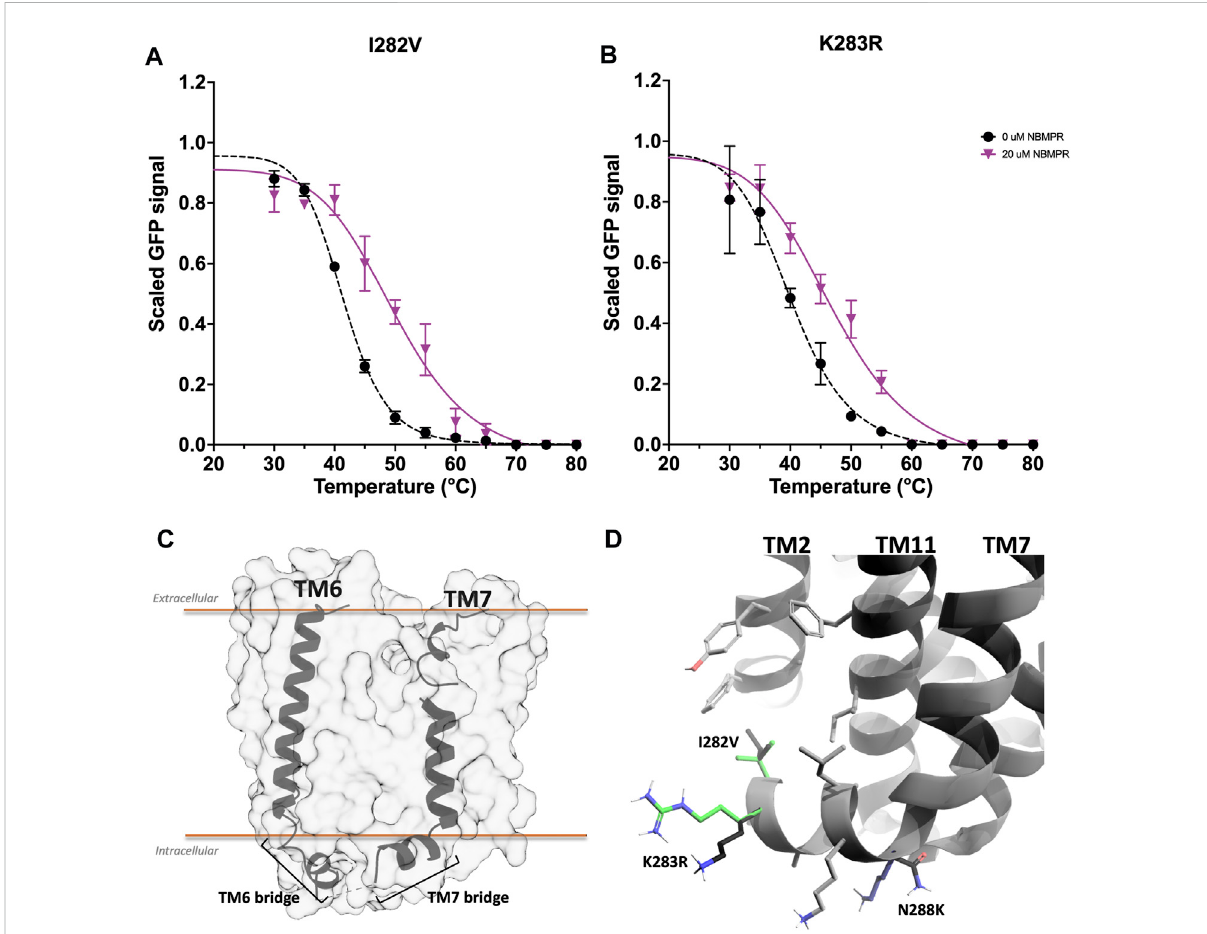
FIGURE 5 Investigation and rationalisation of variants I282V and K283R stabilisation of hENT1. Data generation, fi tting and error analysis performed as detailed in wild type. (A) I282V apo -state curves were collected as an average of 12 repeats, whereas NBMPR-bound curves were collected as an average of 3 repeats. (B) K283R apo -state curves were collected as an average of 12 repeats, whereas NBMPR-bound curves were collected as an averageof3repeats. (C) AperpendicularviewofTM6andTM7.TM1-5andTM8-11removedforclarity. (D) Aclose-upperpendicularviewofthe intracellular region of the TM7 bridge of hENT1. The side chains of neighbouring native residues are shown in grey. Mutations I282V and K283R are showningreen.TheintracellularkinkofTM7isalsothelocationofoneofthethreestabilisingmutations(N288K,showninblue)thatwasintroduced by Wright & Lee to generate a crystallisable hENT1 construct (Wright and Lee, 2019). Native residues of all mutations are shown in